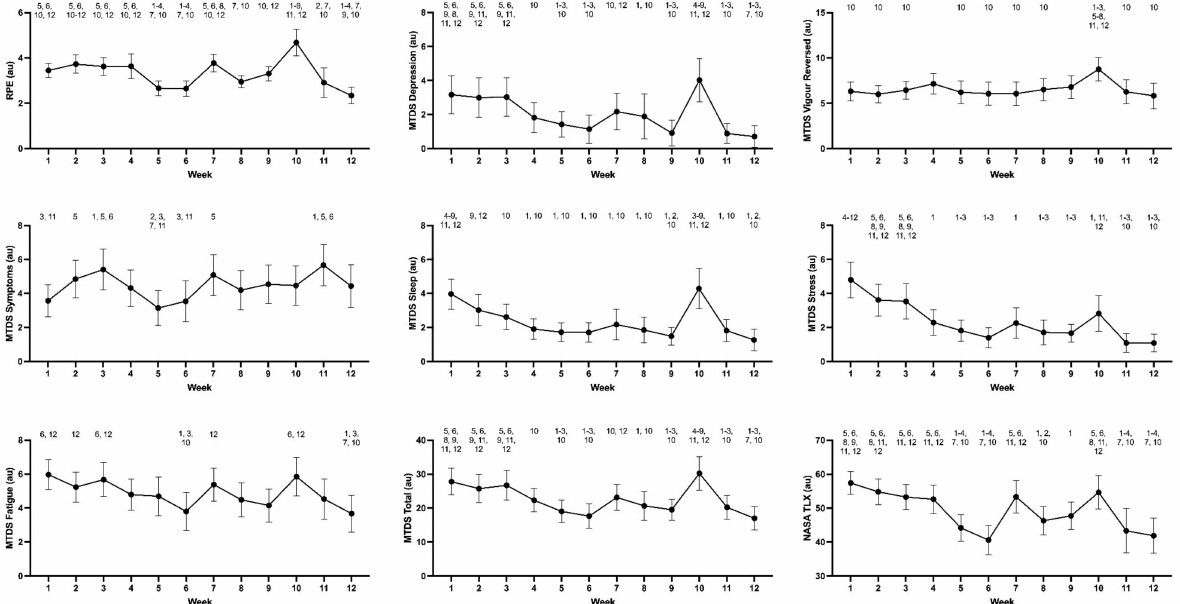
Figure 2. Changes in subjective assessments of training demands and wellbeing across the 12-week BMT program (mean ± 95% confidence intervals). Note: RPE, rating of perceived exertion; MTDS, multi-component training distress scale; NASA TLX, National Aeronautical Space Agency task load index; au, arbitrary units. Numbers above data points denote a significant difference to the detailed week ( p <